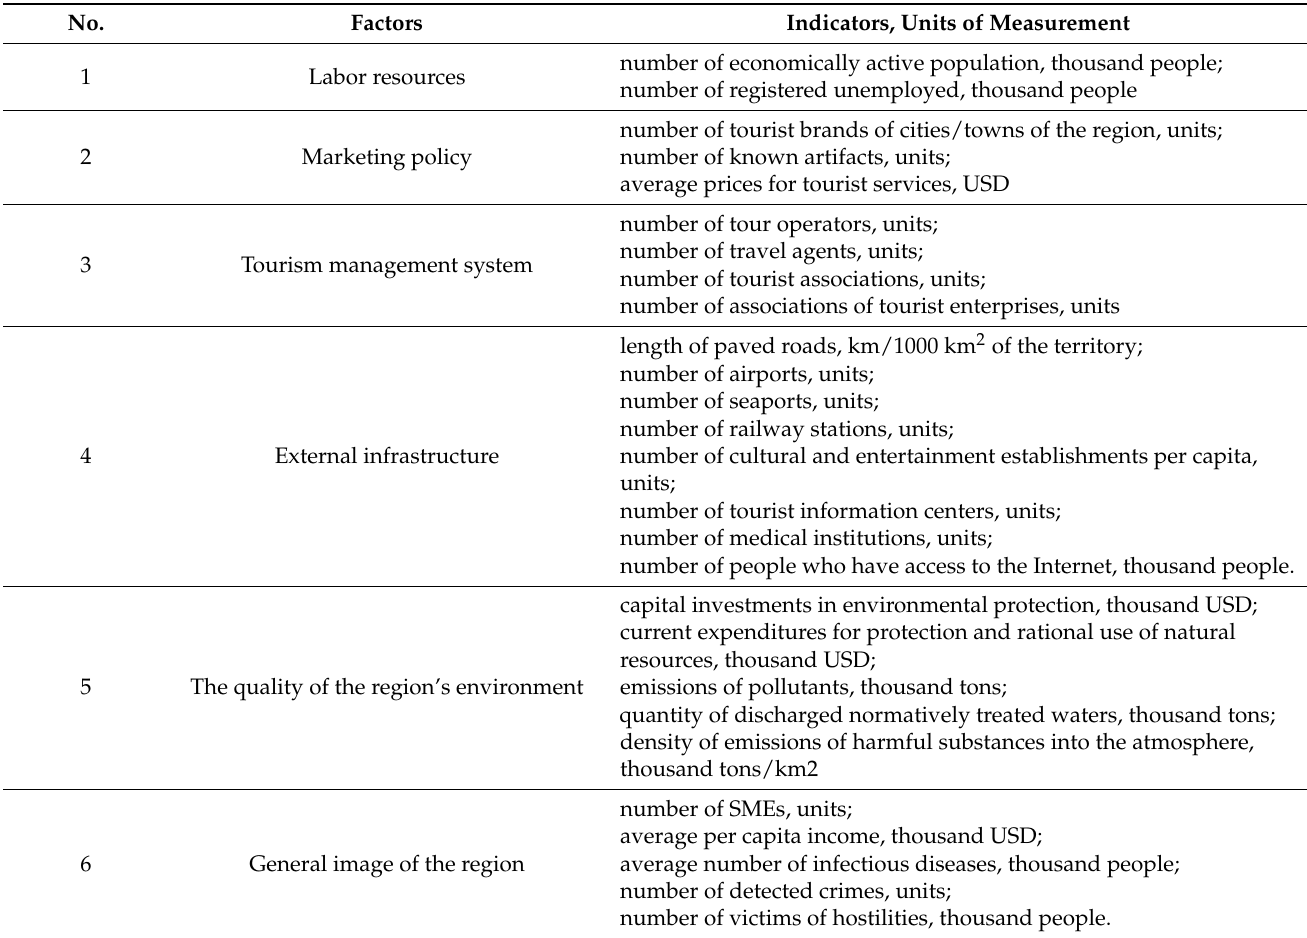
Table 2. The main indicators for assessing the impact of external direct factors on the level of use of the region’s tourism